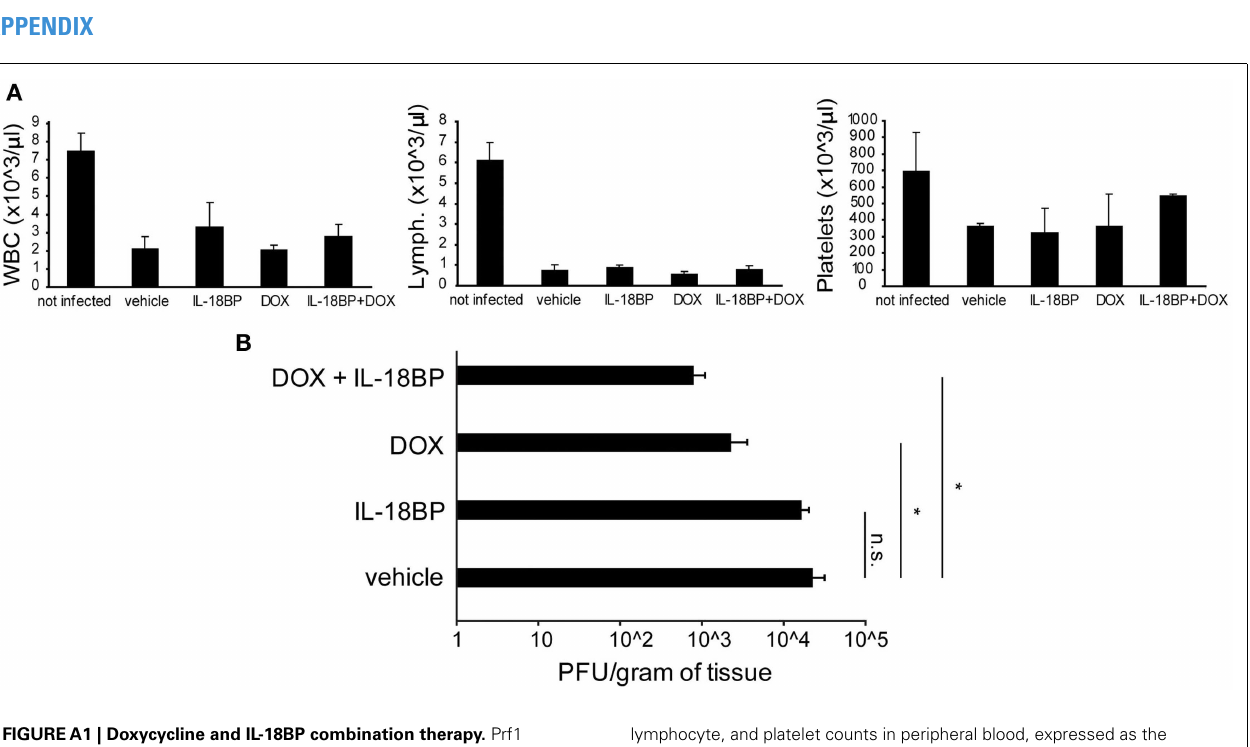
lymphocyte, and platelet counts in peripheral blood, expressed as the mean ± SEM of four mice per group. * p < 0.05; n.s., not significant. (B) Viral titers in the liver, expressed as the mean ± SEM of three mice per